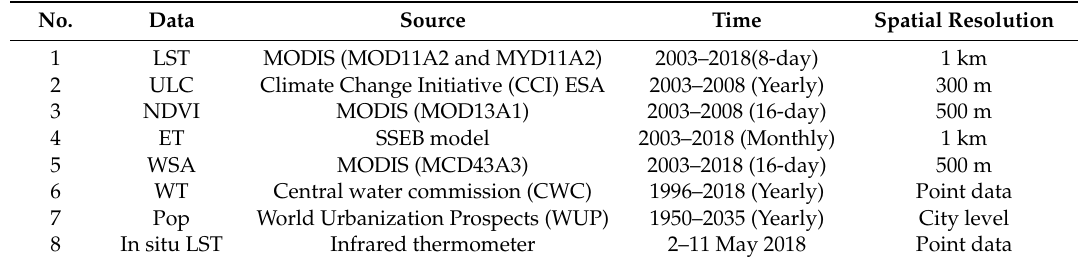
Table 1. Data sets used in this